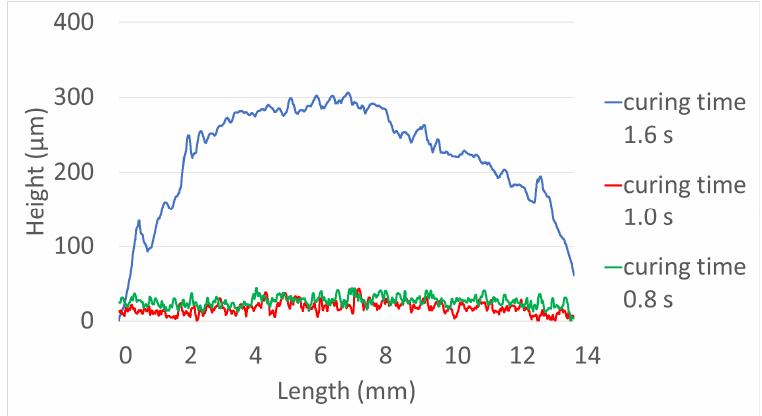
Figure 13. Surface pro fi le—Green body specimens according to various curing times.